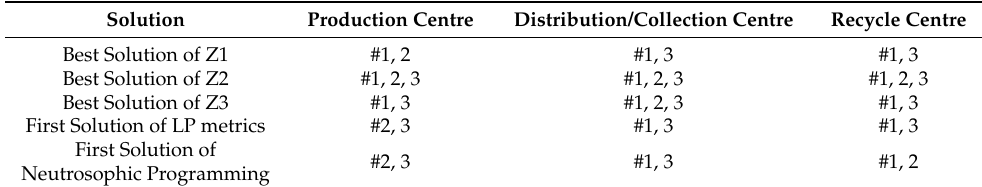
Table 6. Optimal locations of potential facilities in the sample